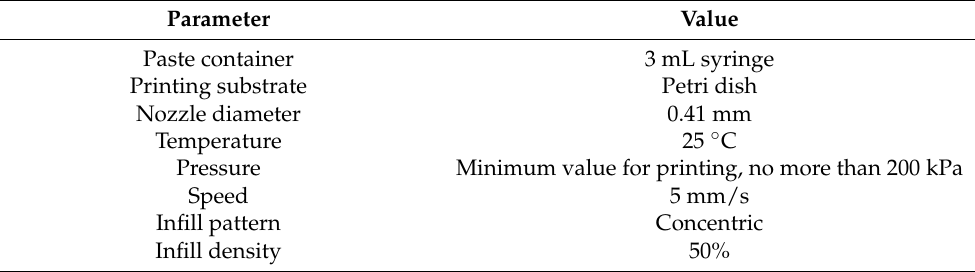
Table 4. Critical parameters and their value in SSE fabrication. Parameter Paste container Printing